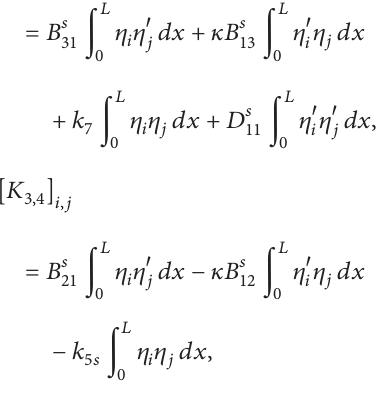
𝐿 𝜉 𝜂 󸀠 𝑑𝑥 ∫ 4 𝑖 𝑗 0 𝐿 𝜂 𝜉 󸀠 𝑑𝑥, ∫ 6 𝑖 𝑗 0 𝐿 𝜂 𝜉 󸀠 𝑑𝑥, ∫ 5𝑠 𝑖 𝑗 0